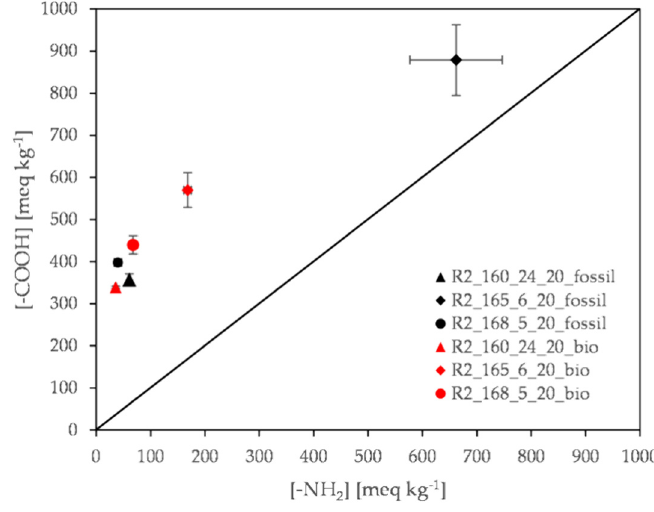
Figure 10. Evaluation of time–temperature profiles tested: amine and carboxyl end group concentra- tion of R2 products.